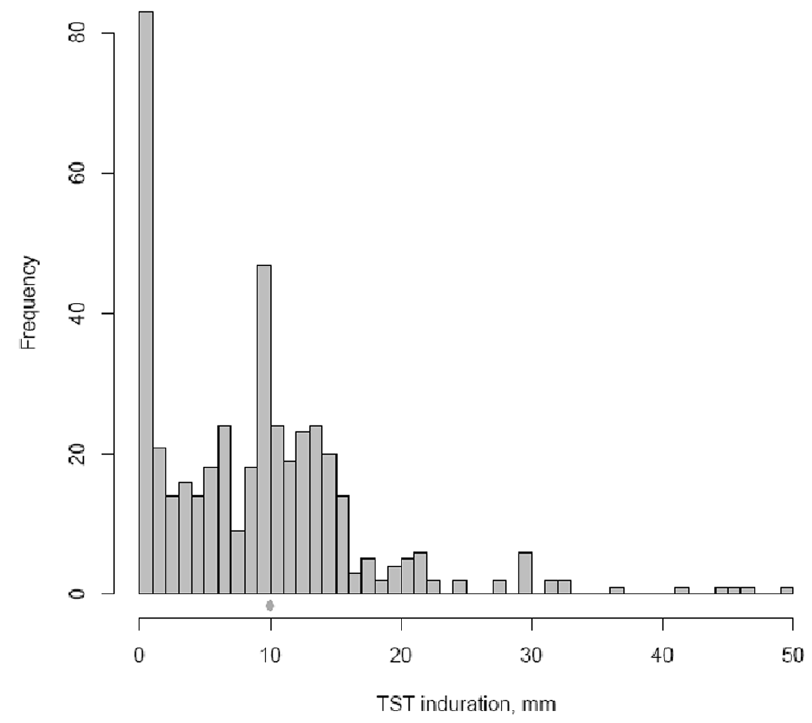
Figure 2. Distribution of tuberculin skin test reactions (induration in mm).